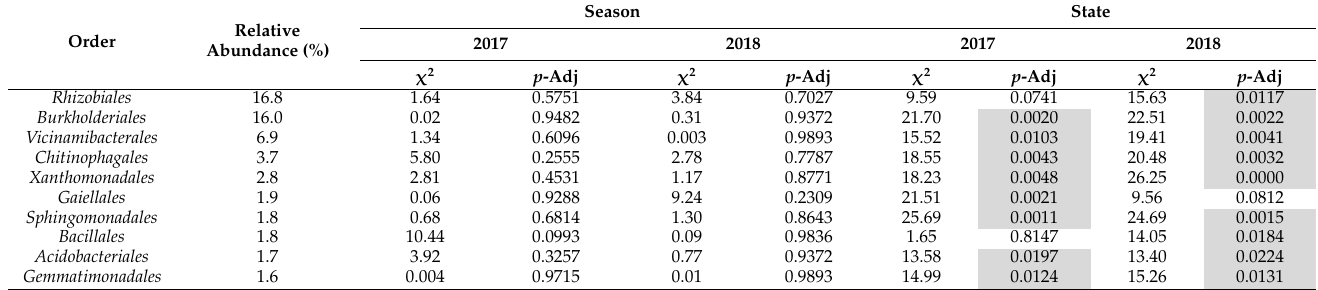
Table 4. Kruskal–Wallis test on the relative abundance of the ten most abundant bacterial orders among the five states/gardens by season and year and between two seasons by state and year.